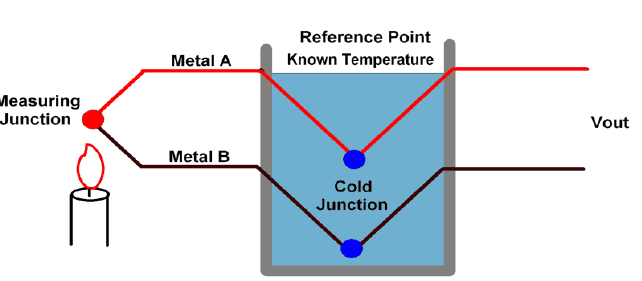
Figure 1. Thermoelectric converter with two dissimilar metals, explaining the Seebeck principle